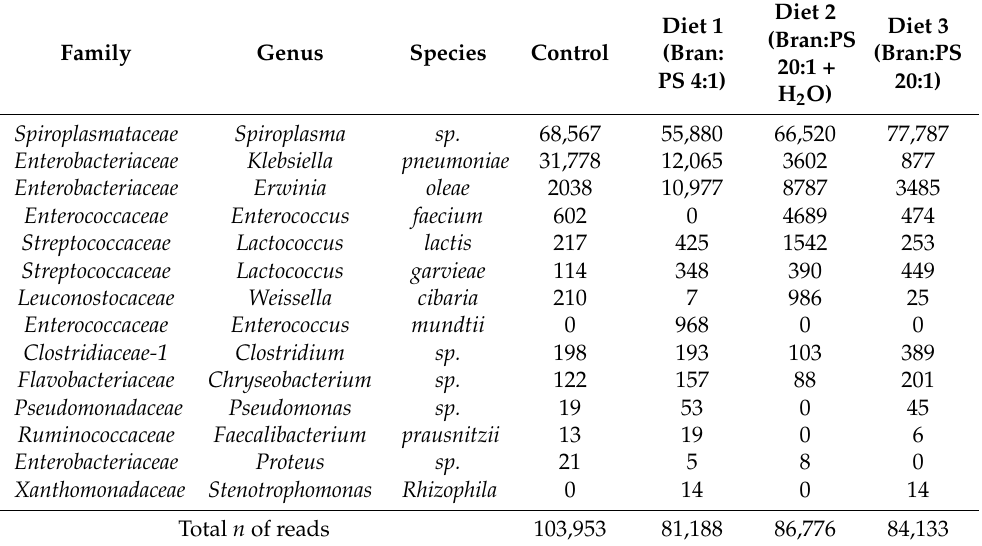
Table 1. Identified bacterial counts in the digestive tracts of mealworm larvae after degrading PS following different feeding